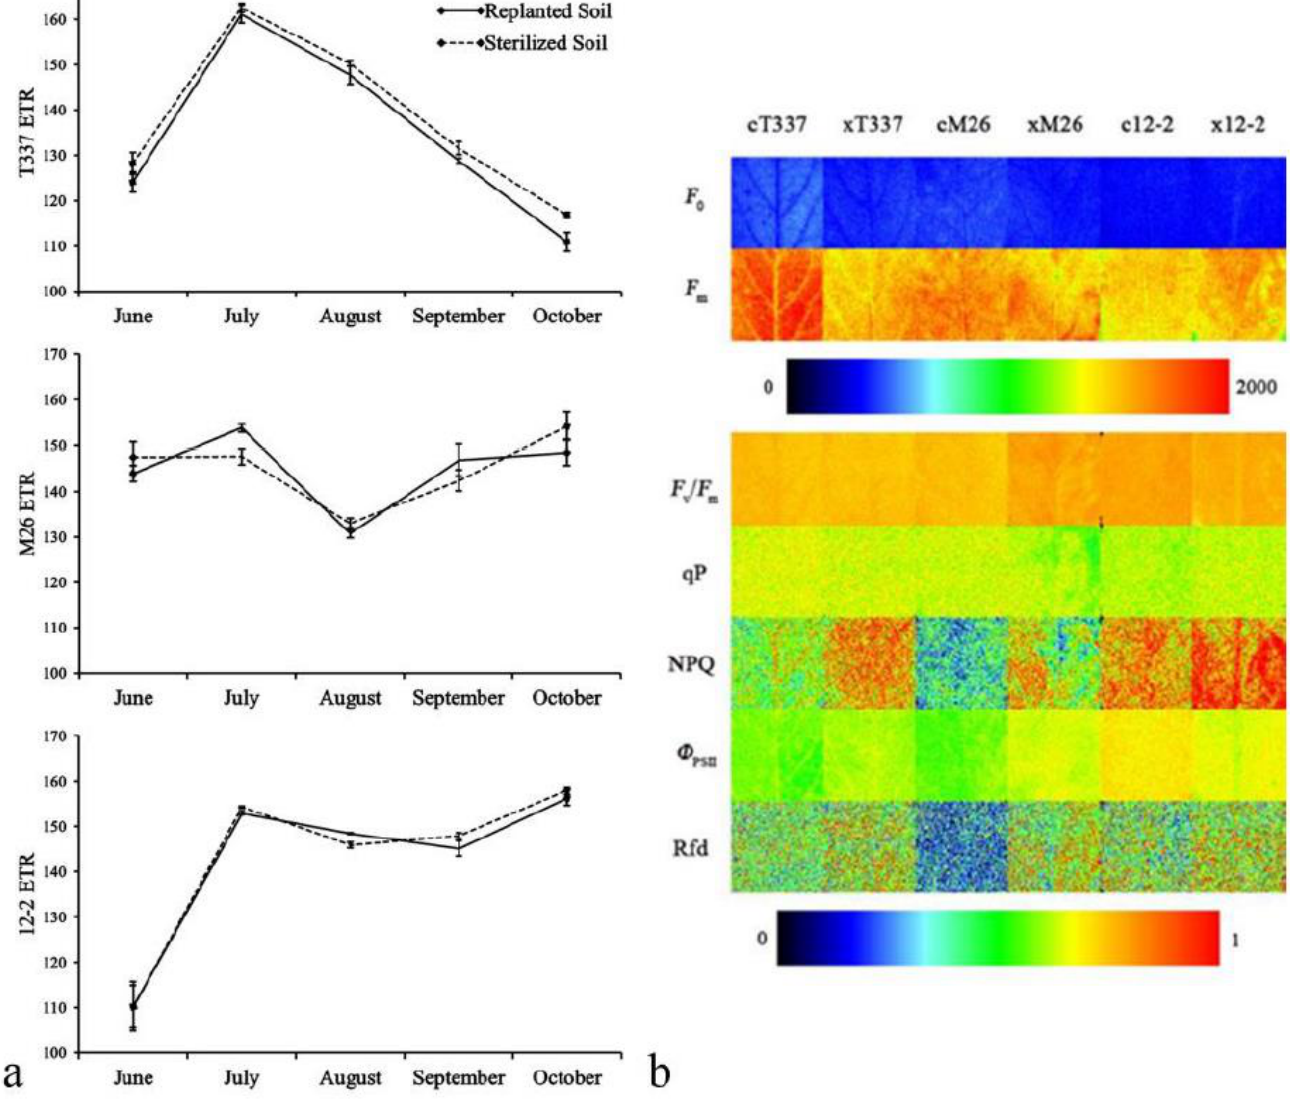
Figure 4. Fluorescence (ETR) ( a ) and the chlorophyll fluorescence imaging system ( b ) in the leaves of the plants with different rootstock types planted in sterilized and replanted soil. cT337, T337 planted in replanted soil; xT337, T337 planted in sterilized soil; cM26, M26 planted in replanted soil; xM26, M26 planted in sterilized soil; c12-2, 12-2 planted in replanted soil; x12-2, 12-2 planted in sterilized soil. F 0 and F m scale is 0–2000, and F v /F m , qP, NPQ, Φ PSII , and ETR scale is 0 – 1.